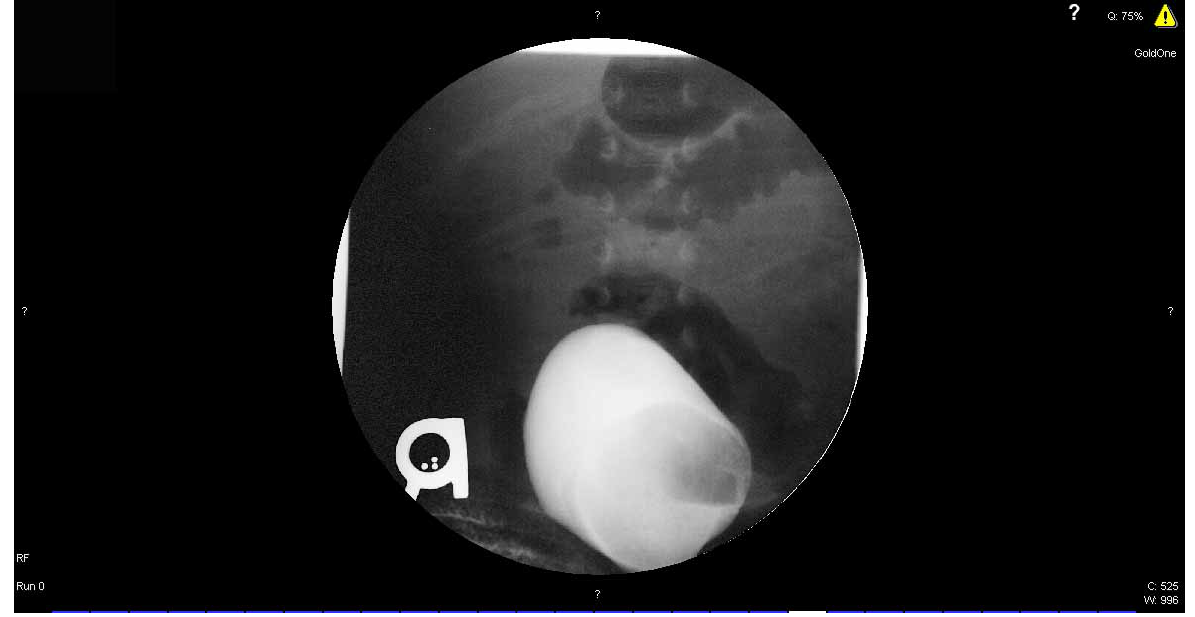
FIGURE 9A . VCU demonstrating shadow of ureterocele within the urinary